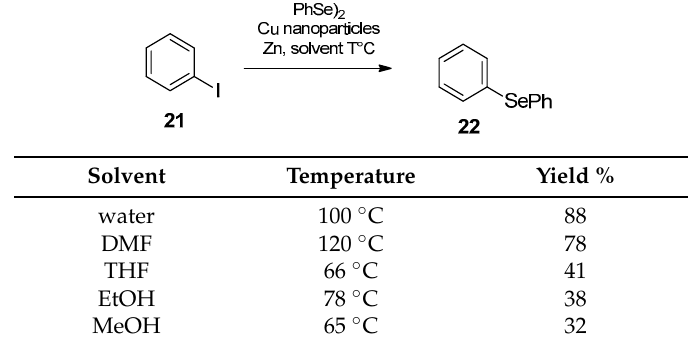
Table 3. Cu nanoparticles catalyzed coupling reaction: comparison of solvents.